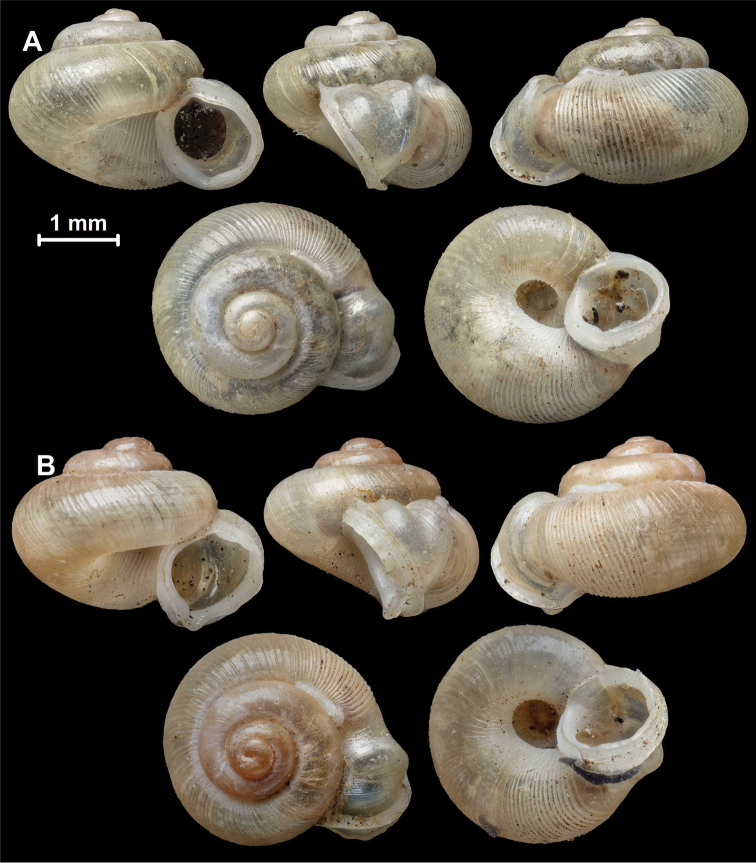
Shells of Dicharax
(?)
birugosus (Godwin-Austen, 1893) AAlycaeus
canaliculus Godwin-Austen, 1914, (NHMUK 1903.7.1.2764) BA.
birugosus Godwin-Austen, 1893, syntype (NHMUK 1903.7.1.2628). Photographs: Kevin Webb (NHM).